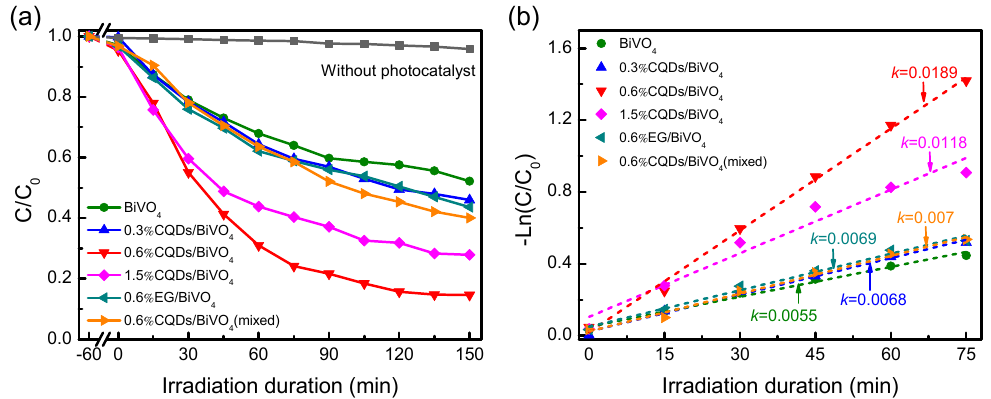
Figure 5. ( a ) Photocatalytic degradation of BzP over different catalysts under visible-light irradiation and ( b ) the corresponding first-order reaction kinetic plots.